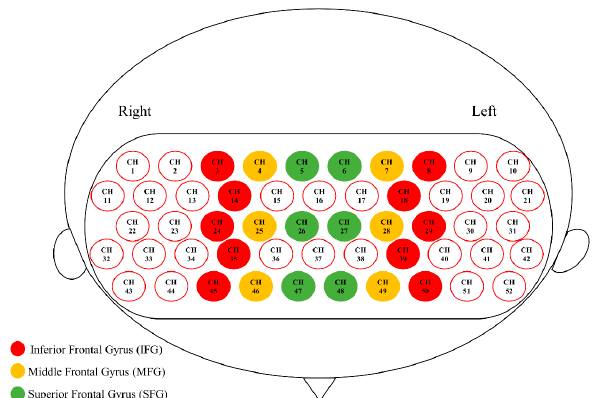
Figure 3. Six anatomically defined ROIs in the prefrontal cortex (PFC).